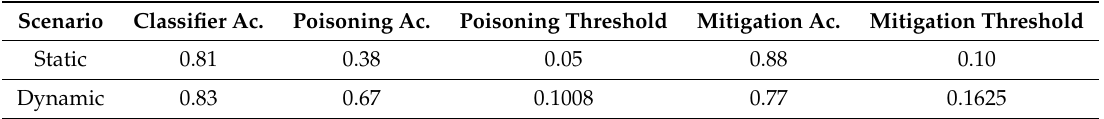
Table 5. Adversarial Attacks and Mitigation New Entries.